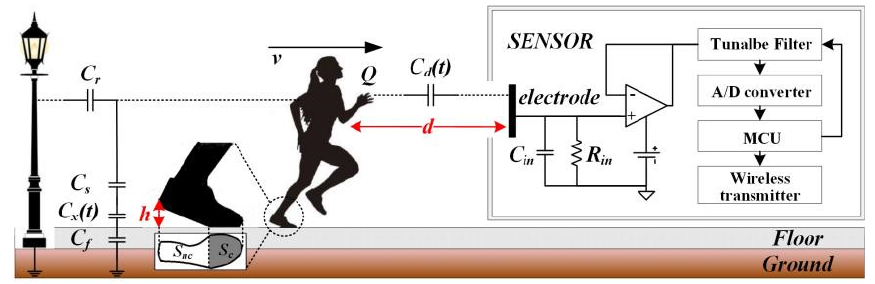
Figure 1. Principle of the electrostatic signal generated by moving the human body. The body will be polarized and charged when the human body is electrostatically insulated from the earth. Furthermore, when the human body is grounded, it distorts the vertical gradient of the atmospheric electric field in its vicinity, generating a measurable electrostatic signal. Indoors, the human body’s static electricity mainly comes from the rapid contact separation between body parts and objects, such as the friction between the sole of a shoe and the ground, the friction between an arm and a desktop, and the friction between clothes. The following is an example of human walking, as shown in Figure 2, to theoretically analyze the feasibility of this method.